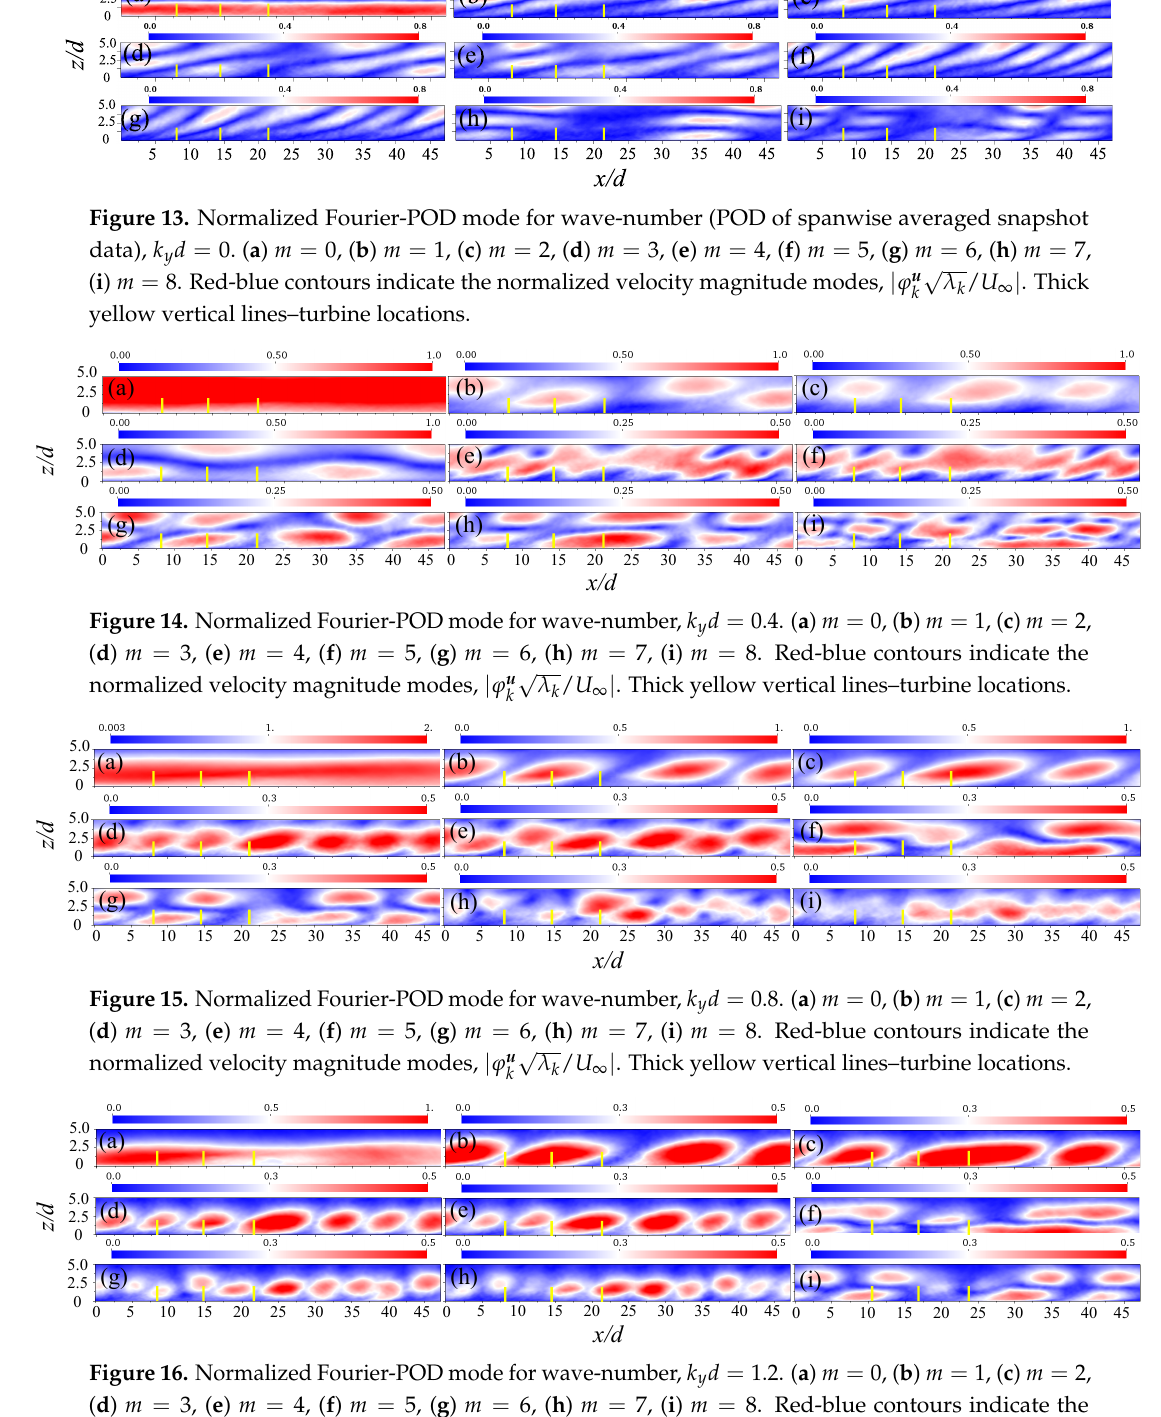
√ λ ϕ u k / U ∞ | . Thick yellow vertical lines–turbine k |